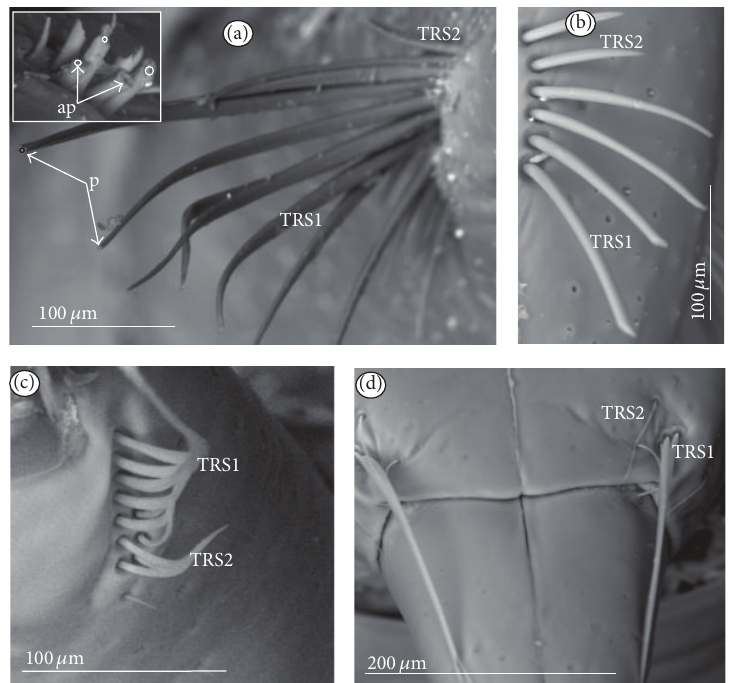
Figure 4: Types and sizes of the trichoid sensilla of the Nepomorpha. (a) TRS1 trichoid sensillum, long, TRS2 trichoid sensillum, short; these sensilla are placed dorsally near the apex of the labium at the fourth segment; in the broken shank of the sensillum, a hole (ap) is visible, and it displays a dendrite running to the tip of the sensillum. (b) TRS1, TRS2 trichoid sensilla; these are individually placed dorsally near the apex of the labium in one row. (c) TRS1, TRS2 trichoid sensilla; these are placed ventrally, near the apex of the labium. (d) TRS1, TRS2 trichoid sensilla; they are placed dorsally on the third labial